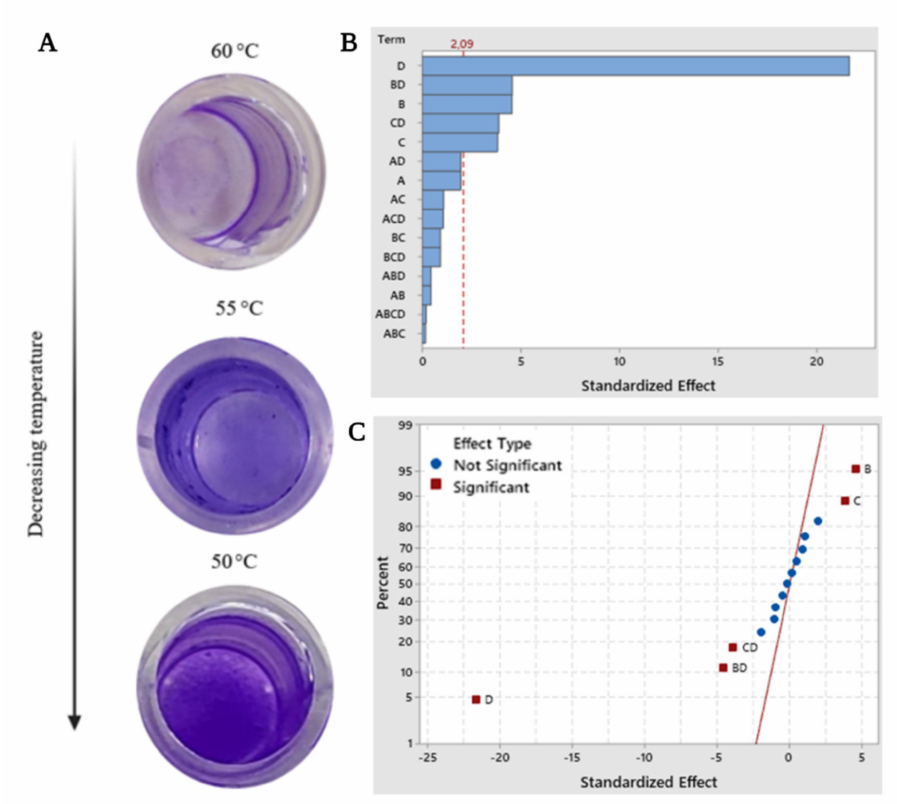
Figure 1. ( A ) Biofilm formation in 96-well microtiter plates after 96 h of incubation showing temperature dependence, factorial analysis of biofilm production (A = glucose as carbon source, B = yeast extract as nitrogen source, C = pH, and D = Temperature, with response in biofilm produc- tion value α = 0.05); where ( B ) Pareto chart of the standardized effects, and ( C ) normal plot of the standardized effects.